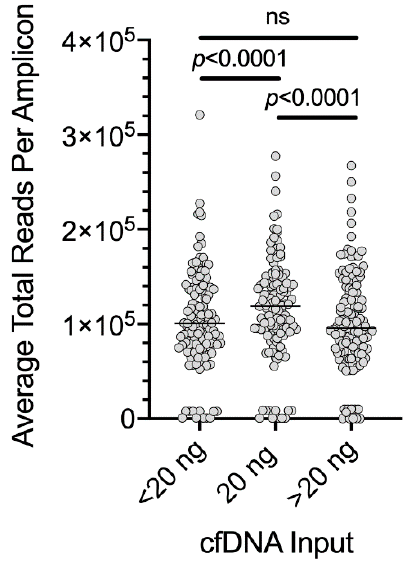
Figure 2. Average total reads obtained for each amplicon in the custom melanoma panel. The input template cfDNA was < 20 ng ( n = 40 samples, range of 3.6–19.1 ng), 20 ng ( n = 21 samples, range of 19.5–20.5 ng) or > 20 ng ( n = 8 samples, range of 21–42 ng). In each case, seven NGS sample libraries were run on an Ion 550 sequencing chip using the Ion Ampliseq HD workflow. Reading depth data for each amplicon for each patient are shown in Table S2. One-way ANOVA with Tukey’s multiple comparison test was performed. ns, not